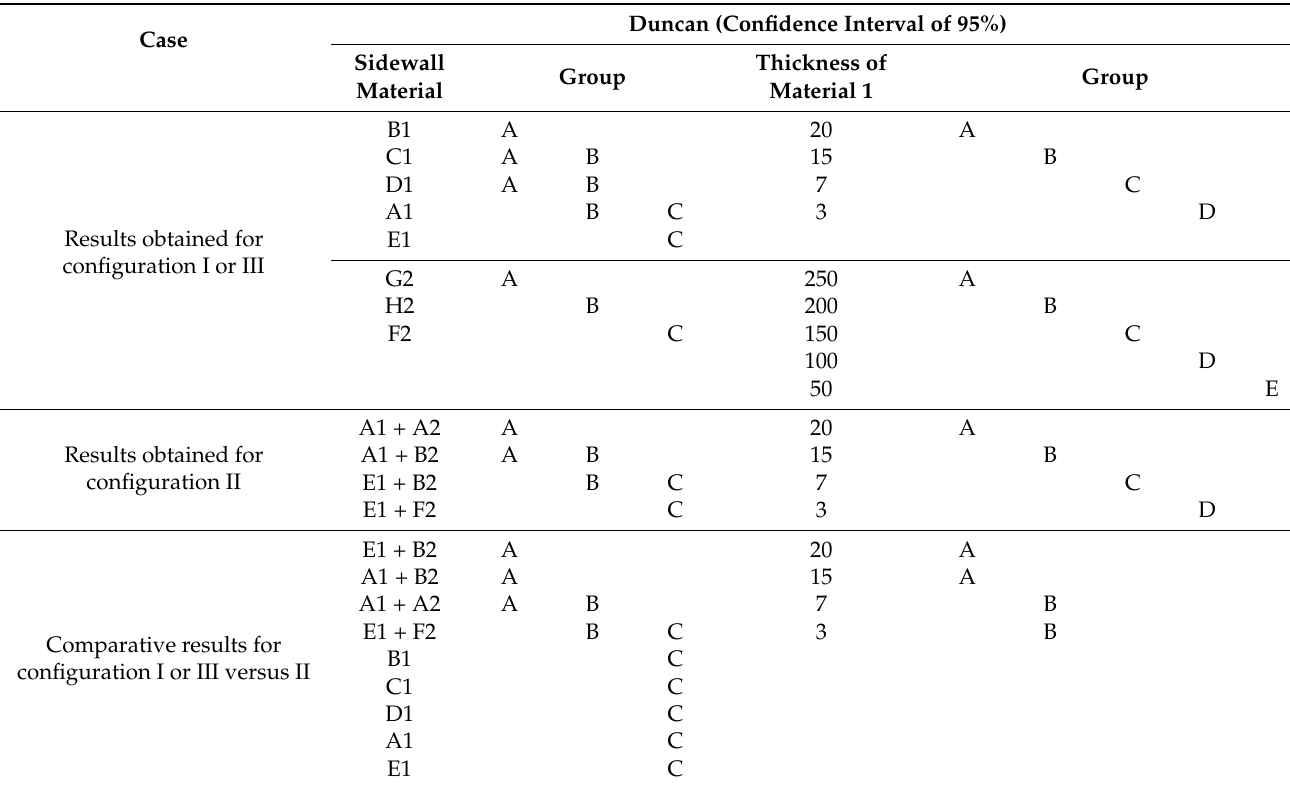
Table 15. Duncan’s test for cooling time using different sidewall configurations, for different materials, and material thicknesses.